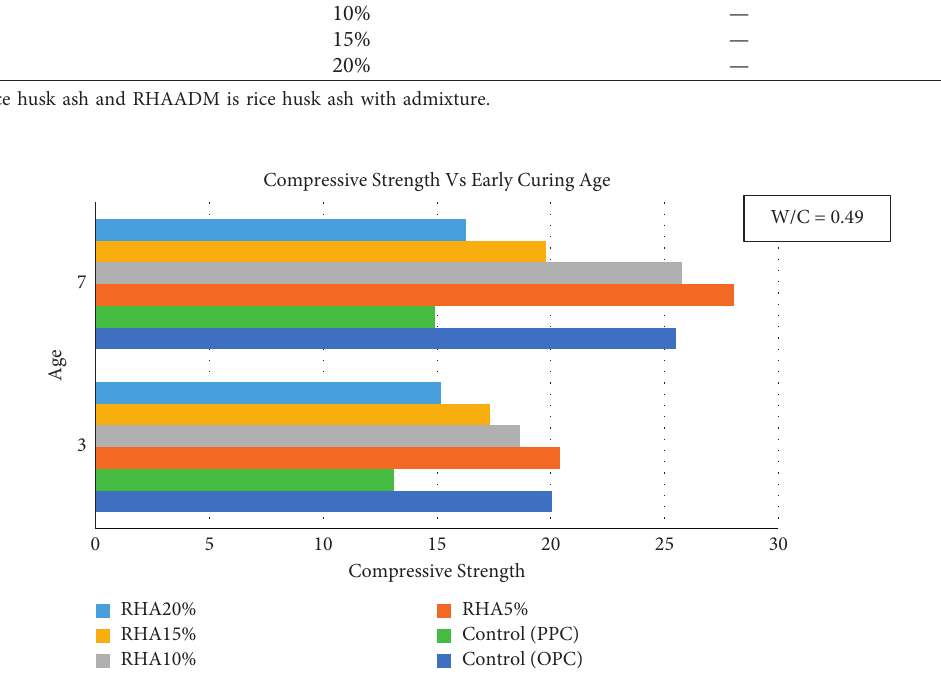
Figure 4: Early compressive strength development at 3 rd and 7 th curing days without